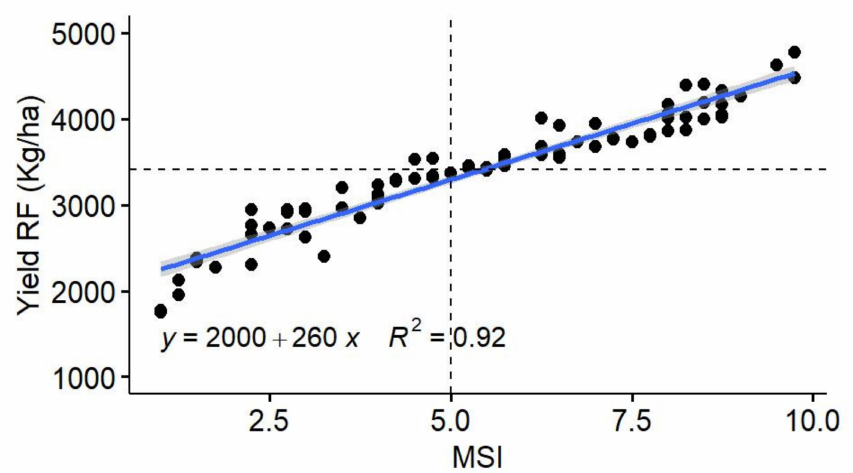
Figure 3. Linear regression and coefficient of determination of the mean score index (MSI) versus grain yield (kg/ha) under drought stressed conditions at Tessaout over two seasons (2016–2017 and